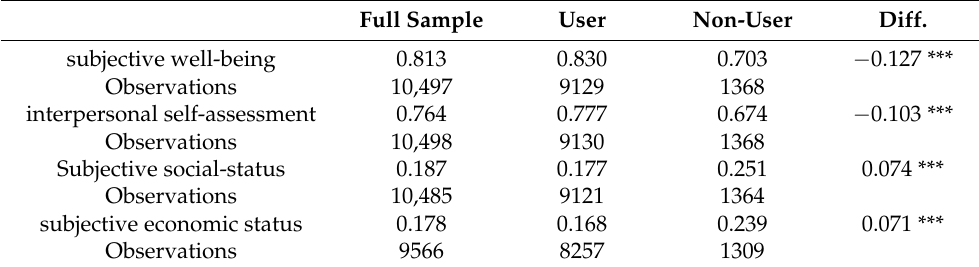
Table 13. Statistics for the intermediates